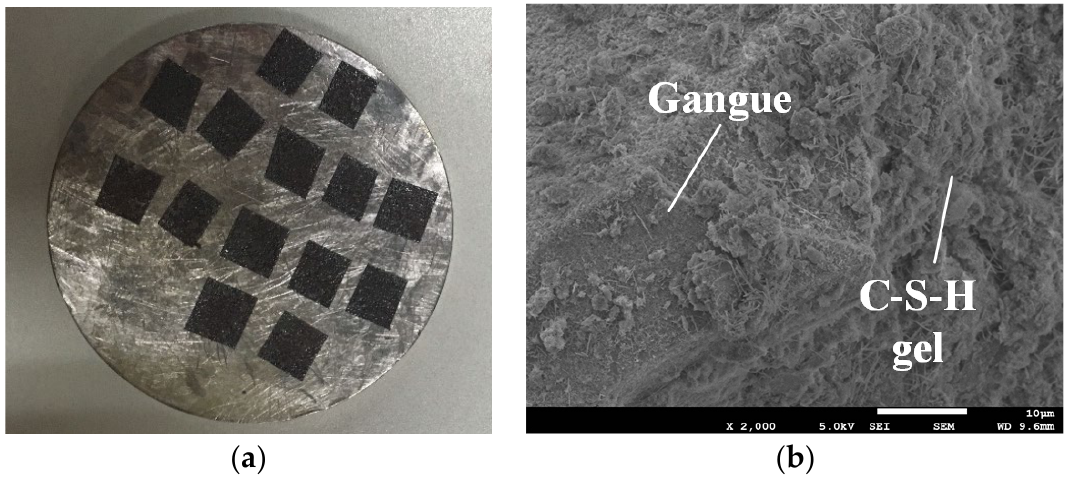
Figure 11. ( a ) Samples used for SEM; and ( b ) C-S-H gel covers the gangue particles.